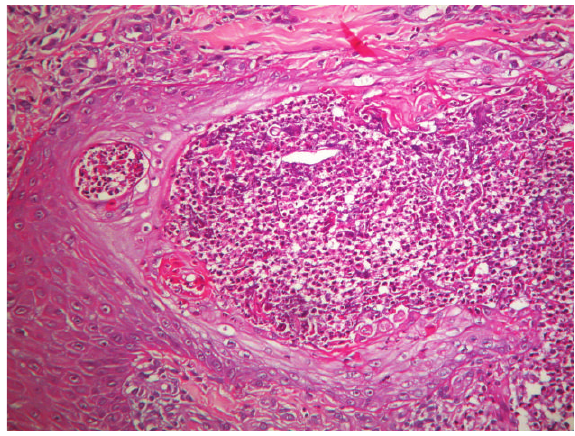
Figure 3: Histological examination demonstrated degenerated col- lagen and fibrosis with a peripheral lymphohistiocytic infiltrate in dermis (haematoxylin and eosin, original magnification × 200).